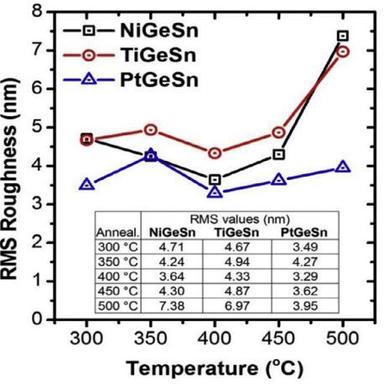
AFM analysis as a function of the different metal and formation temperature. As inset there is a table with all the RMS values of NiGeSn, TiGeSn and PtGeSn formed from 300 °C up to 500 °C.